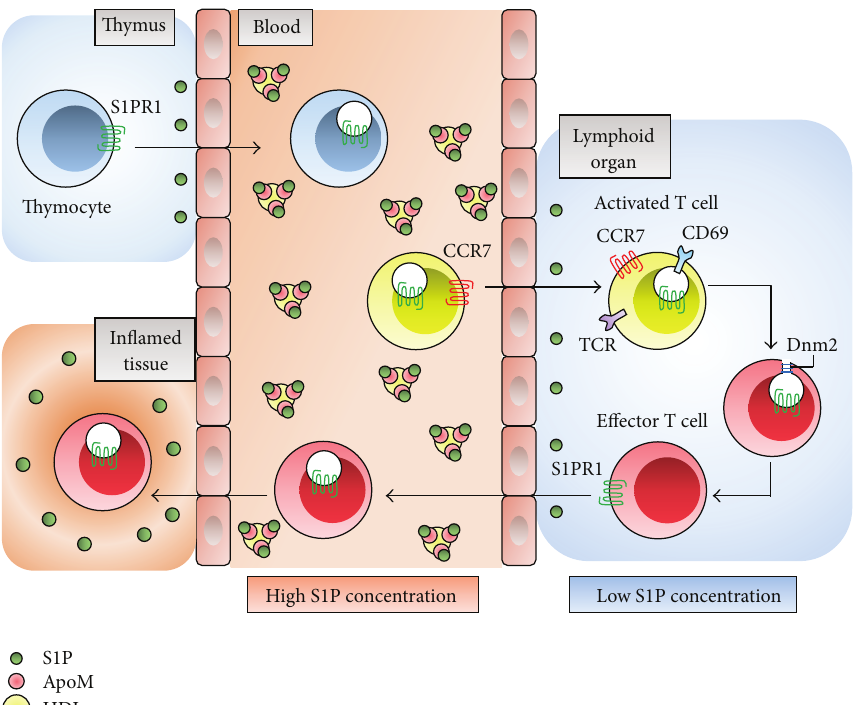
Figure 1: The role of S1P-S1PR1 axis in T cell trafficking. S1P is maintained at low concentration in the thymus and lymphoid organs and is in high concentration in blood, binding to ApoM in HDL particles. S1PR1 expression in T cells is downregulated in blood, and T cells are shifted into lymphoid organs with CCR7 signaling. CD69 forms a complex with S1PR1 and downregulates S1PR1 to promote retention in activated T cells. Because Dnm2 enables continuous S1PR1 signaling in lymphocytes, effector T cells can sense low S1P condition and egress from lymphoid organs. ApoM: apolipoprotein M; HDL: high-density lipoprotein; CCR7: CC-chemokine receptor 7; TCR: T cell receptor; Dnm2: dynamin